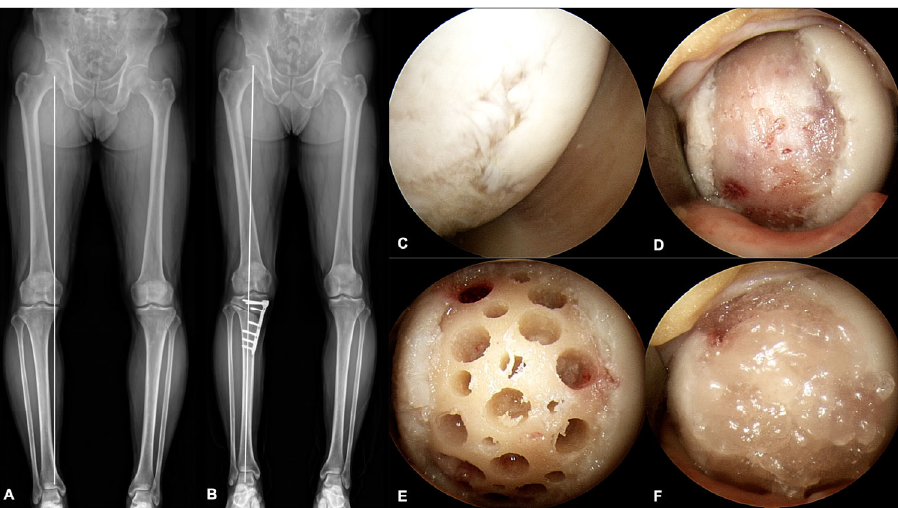
Figure 2. Surgical procedure of implantation for the allogeneic UCB-MSCs-HA composite and combined HTO. ( A ) Preoperative whole-lower-extremity radiograph showed varus limb alignment. ( B ) Postoperative whole-lower-extremity radiograph showed valgus limb alignment after HTO. ( C ) Arthroscopic inspection and confirmation of ICRS 3 and 4 cartilage defect. ( D ) Cartilage defect preparation for underlying healthy subchondral bone and peripheral margin. ( E ) Multiple drill holes in the cartilage defect site. ( F ) Implantation of the UCB-MSCs-HA composite into drill holes and cartilage defect surface (Cartistem ®